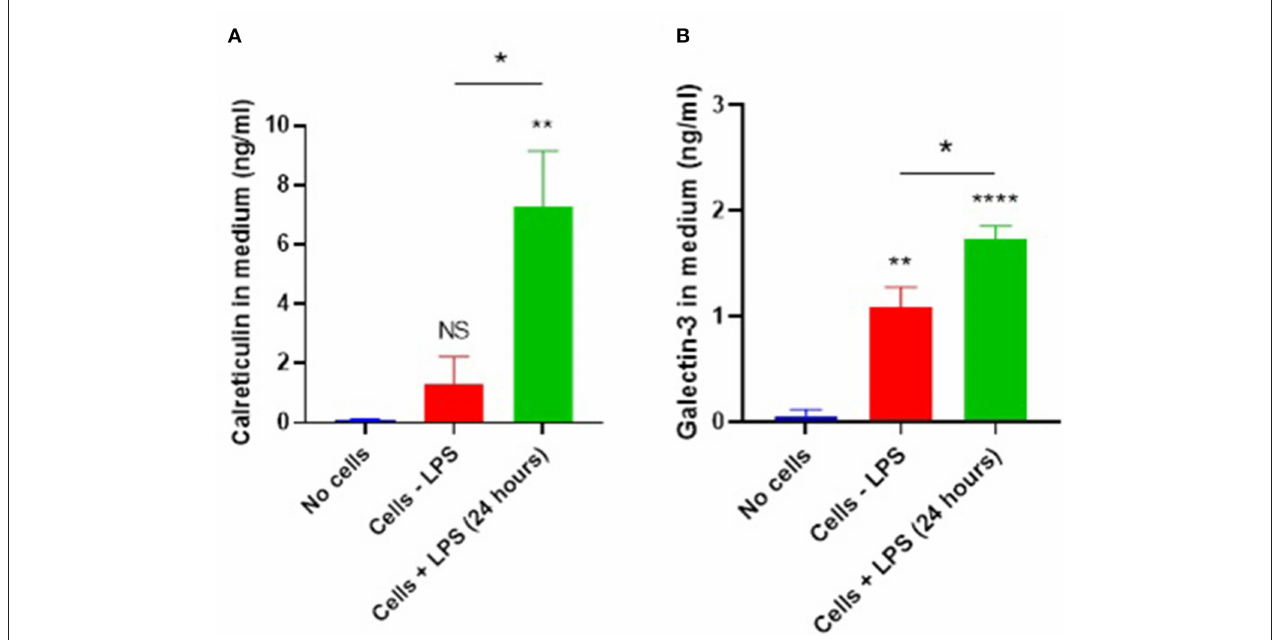
FIGURE 1 | Microglial calreticulin and galectin-3 are released extracellularly following LPS stimulation. (A,B) Primary microglia from mice were treated with vehicle or LPS (100ng/ml) for 24h. Cell-conditioned supernatant was tested for calreticulin protein (A) or galectin-3 (B) presence via ELISA and compared with the “no cells” control. Statistical comparisons were made via one-way ANOVA. Values are means ± SEM of at least three independent experiments. NS p ≥ 0.05, * p < 0.05, ** p < 0.01, **** p < 0.0001 vs. controls, except where indicated by bars over relevant